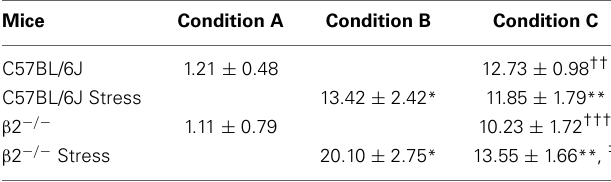
Table 3 | Plasma corticosterone levels ( μ g/dl) in different experimental